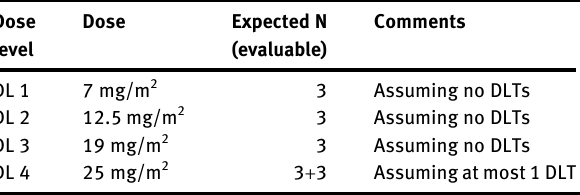
(Table 4). Few PIPAC centers have administered PIPAC-MMC at